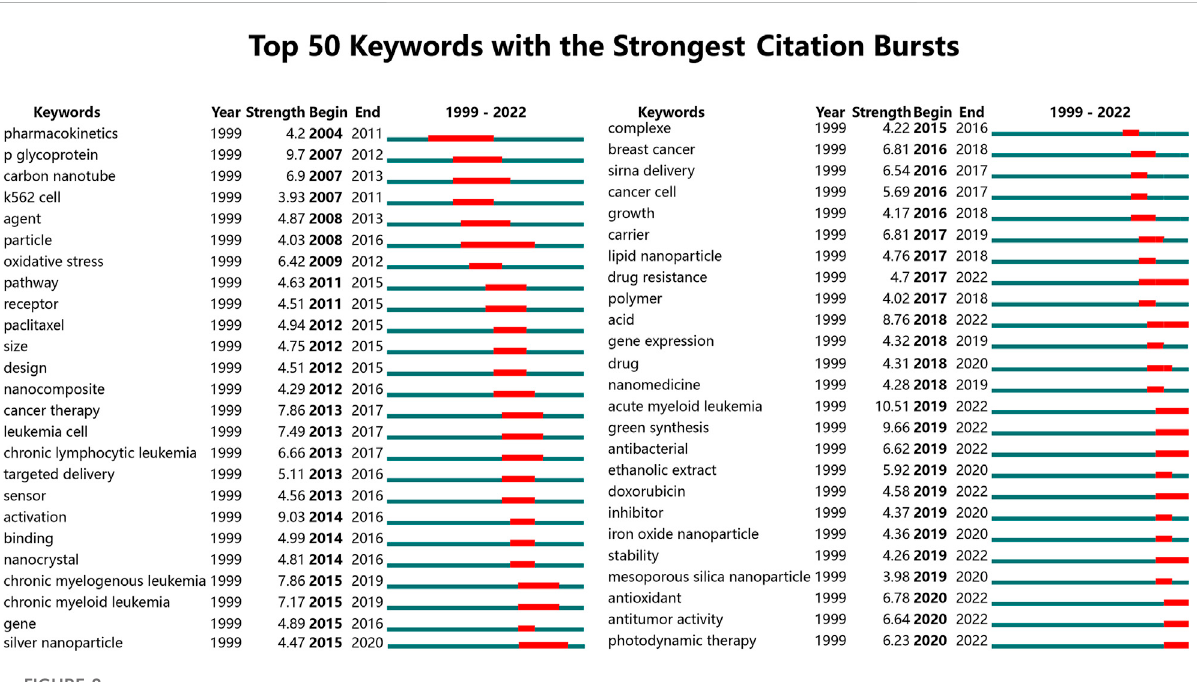
TABLE 6 Top 10 co-cited references for Nanoparticles-leukemia-related research. RANK ID Title Journal Co-